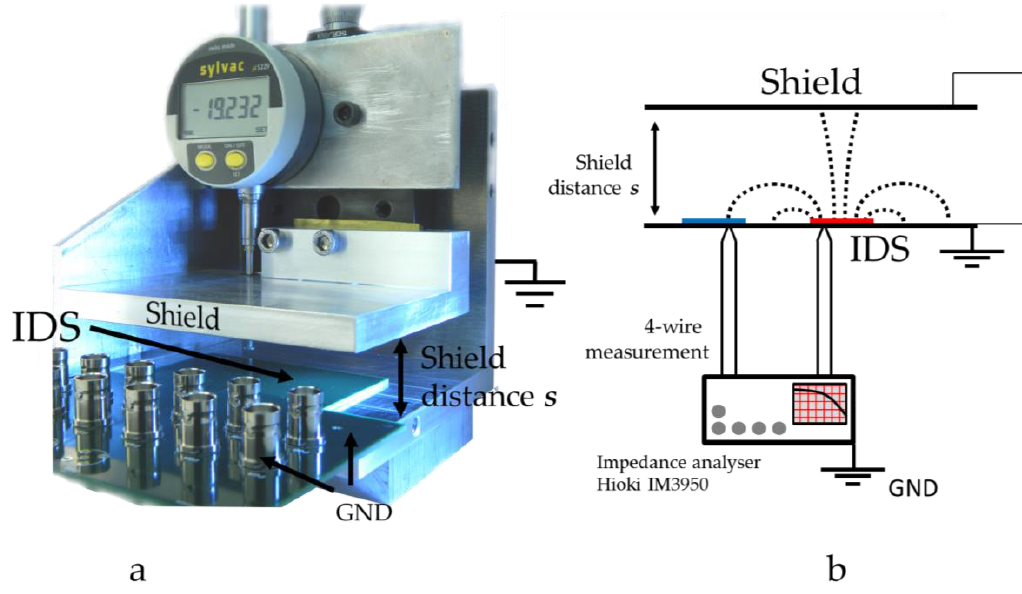
Figure 4. ( a ) Photo of the experimental setup. The photo was taken with an open side for visualization purposes; ( b ) Schematic of the experiment. Table 1. Measured dimensions of the fabricated sensor in a cross-sectional view. The permittivity of the soldermask and insulator layer have been determined to be 4.5 [25,26].